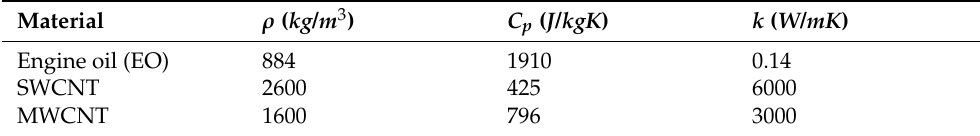
Table 2. Material specifications at 20 ◦ C